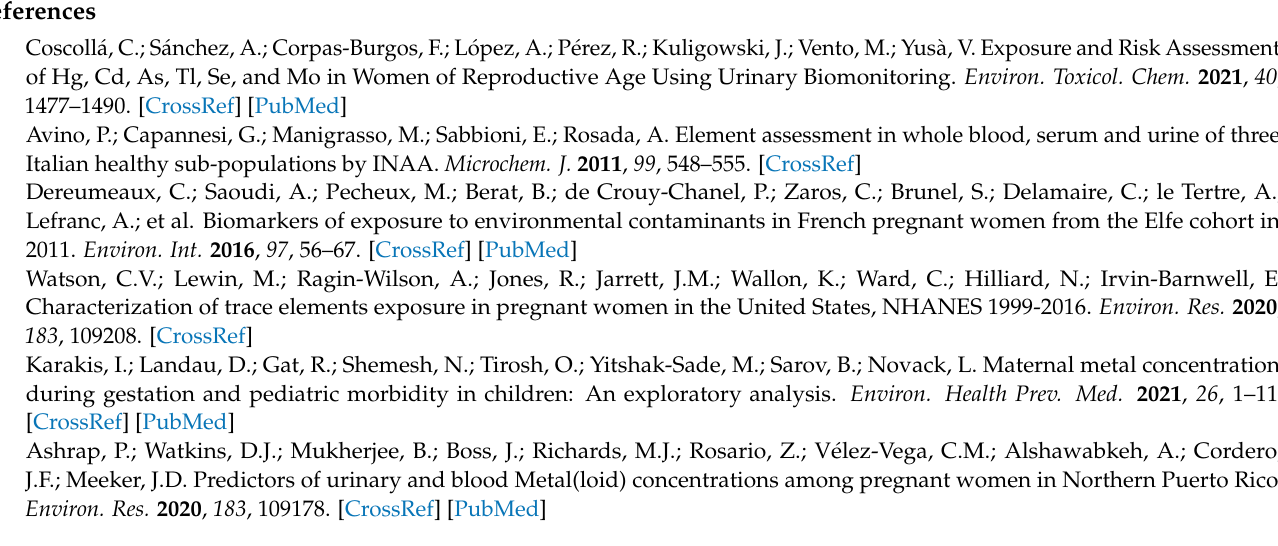
LoQ; Table S2: ICP-MS instrumental operating conditions; Table S3: Determined limits of detection (LoD) and limits of quantification (LoQ); and Table S4: Results for the Clinchek—Control/Urine control lyophilized/RECIPE Level I and